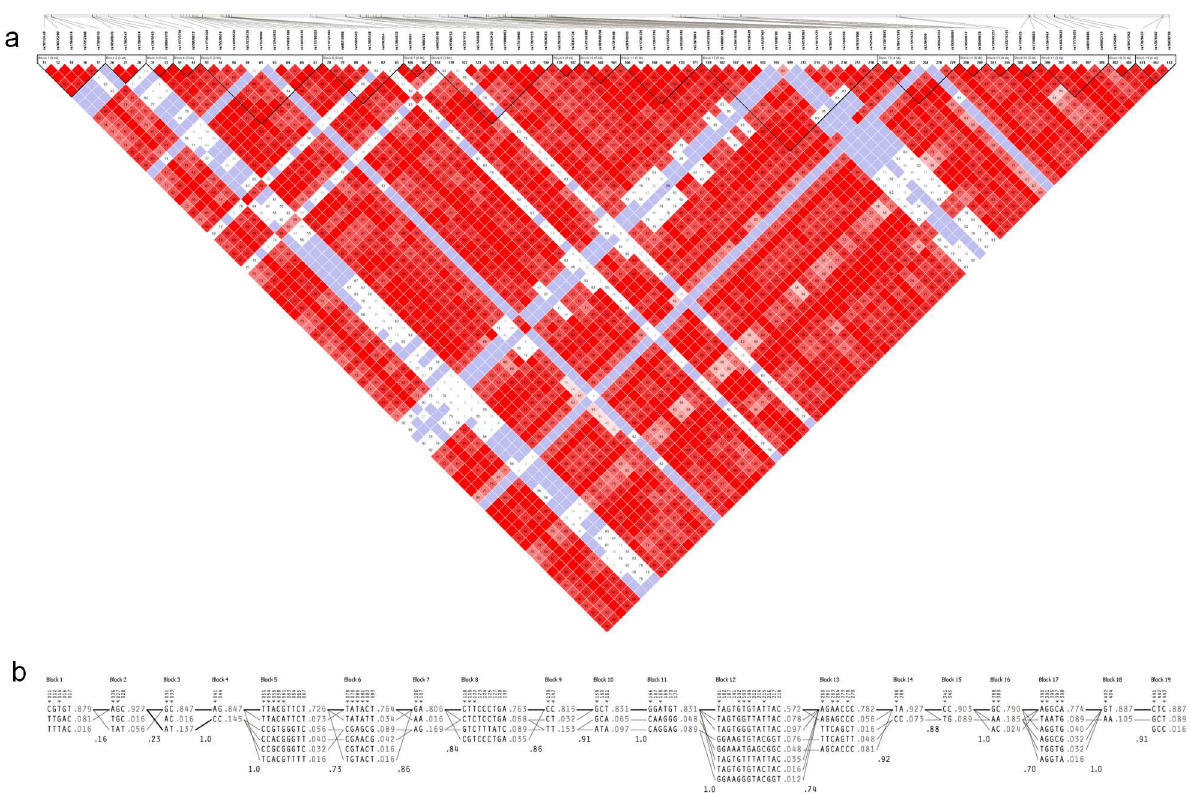
Fig 1. Analysis of haplotype structures at CYP2C19locus in the Orang Asli. (a) Linkage disequilibrium map showing19 haplotype blocks along with the reference SNP cluster ID (rs). Bright red depicts very strong LD (LOD (cid:21) 2; D’ = 1), pink red (LOD (cid:21) 2; D’ < 1) and blue (LOD < 2; D’ = 1) for intermediate LD and white for no LD (LOD < 2, D’ < 1) between the pair of SNPs. Numbers in the square were the D’ value multipliedby 100. (b) Haplotypestructures of CYP2C19with tagged SNP indicatedby an inverted triangle. Frequency of each haplotypeis shown at the edge and the multi-allelic D’ value between each block is shown beneath. The most common crossings between haplotypes are indicatedby thick lines whereas less common crossings are indicatedby thinner